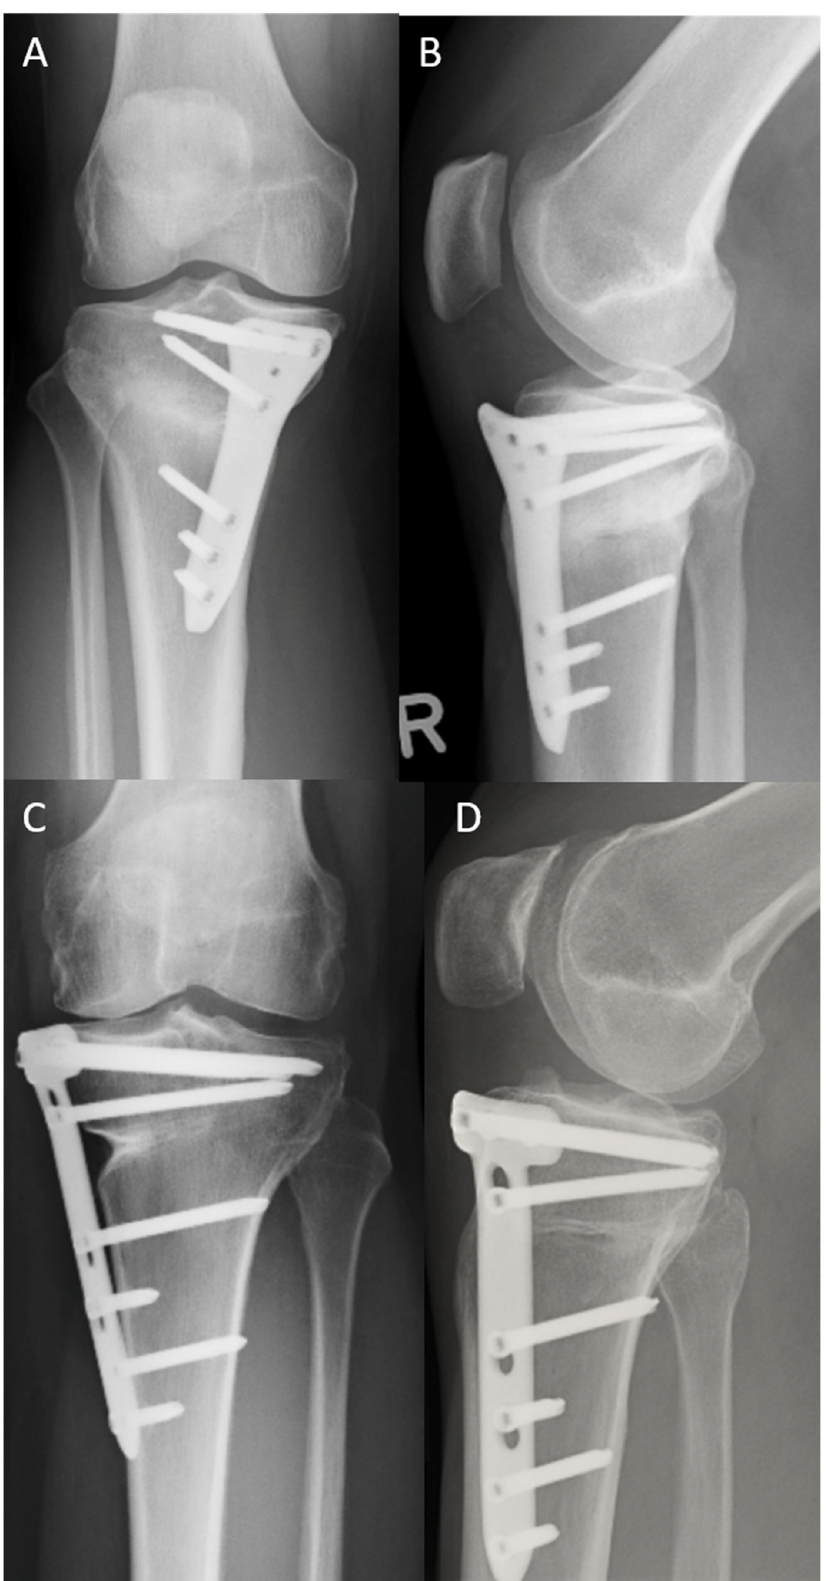
Figure 5. Post-operative X-rays before implant removal: ( A ) LOQTEQ ® HTO plate (aap Implants, Berlin), knee a.p.; ( B ) LOQTEQ ® HTO plate (aap Implants, Berlin), knee lateral; ( C ) TomoFix™ plate (Synthes, Switzerland) knee a.p.; ( D ) TomoFix™ plate (Synthes, Switzerland), knee lateral.